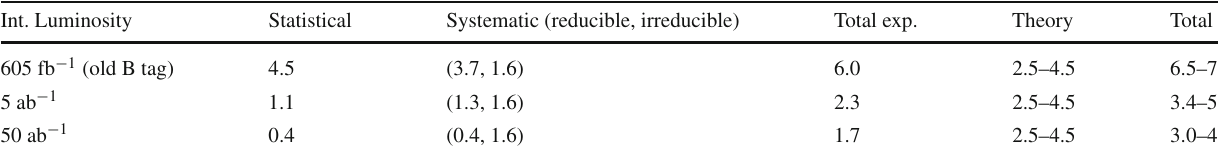
Table 6 Expected percentage uncertainties in inclusive | V ub | measurements with the Belle full data sample, 5 ab − 1 and 50 ab − 1 Belle II data [108] Int.